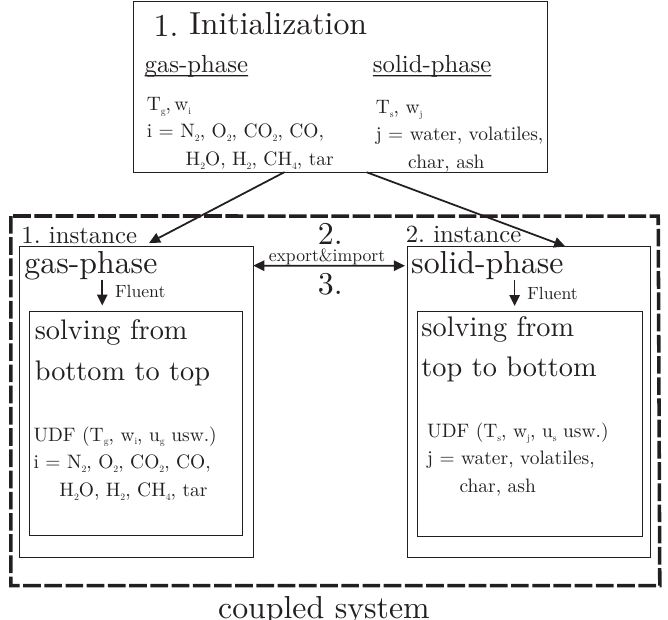
Figure 5. Solution procedure for the CFD Solver of gas-phase and solid-phase equations